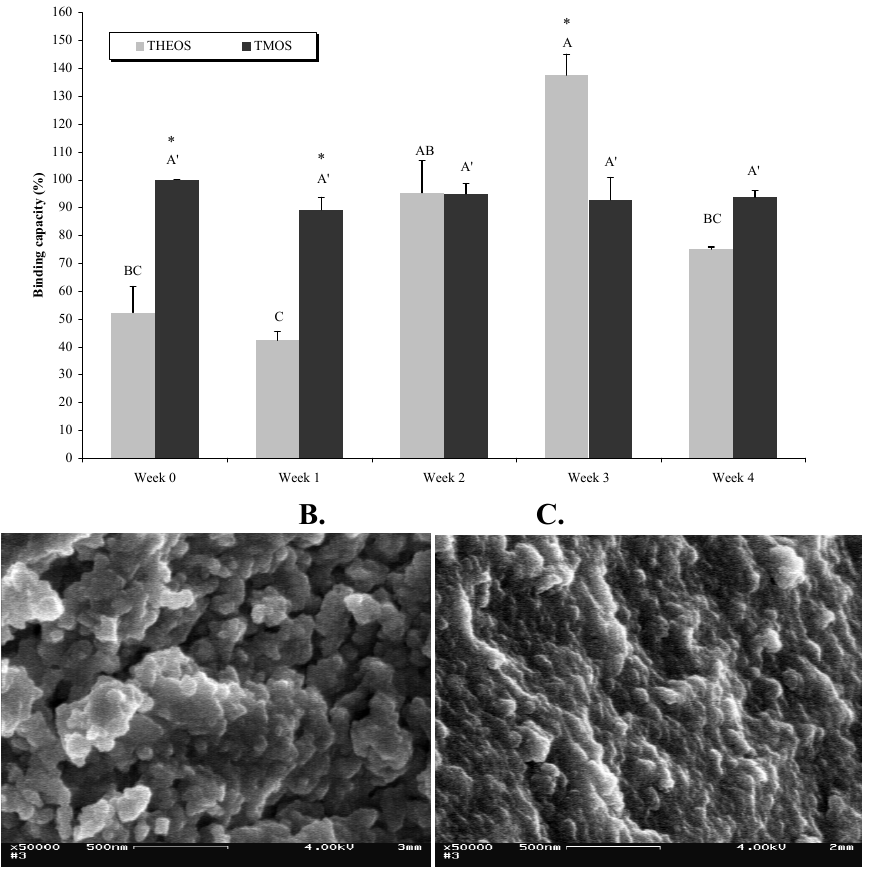
Figure 5. Effects of aging on matrix structure and on Abs activity. ( A ) LNG (100 ng) was loaded on columns containing sol-gels based on TMOS at a TMOS:HCl ratio of 1:8 containing 10% of 0.4-kDs PEG, or on THEOS at a THEOS:HCl ratio of 1:8 without PEG, as precursors. The columns were stored for periods of 1 day (Week 0) up to 4 weeks at 4  C. Amounts of eluted LNG were determined by ELISA. Binding capacity represent the ratio (expressed as a percentage) between the amounts of LNG recovered from a TMOS or THEOS column at each time point and that from a freshly prepared TMOS sol-gel column (Week 0, designated as 100%). Each vertical bar represents the mean  S.E.M of two experiments. Statistical analysis compared the binding capacity of doped TMOS- or THEOS-based sol-gel columns separately as a function of aging (indicated by letters) and of the binding capacity of TMOS vs . THEOS at each time point (indicated by an asterisk). Means with the same letter did not differ significantly at p < 0.05. Means marked with an asterisk (*) differed significantly at p < 0.05. ( B ) and ( C ), respectively, are SEM images of freshly prepared and 4-week-old TMOS-based sol-gels with a TMOS:HCl ratio of 1:8 containing 10% of 0.4-kDa PEG. Magnification, × 50,000; scale bar represents 500 nm.